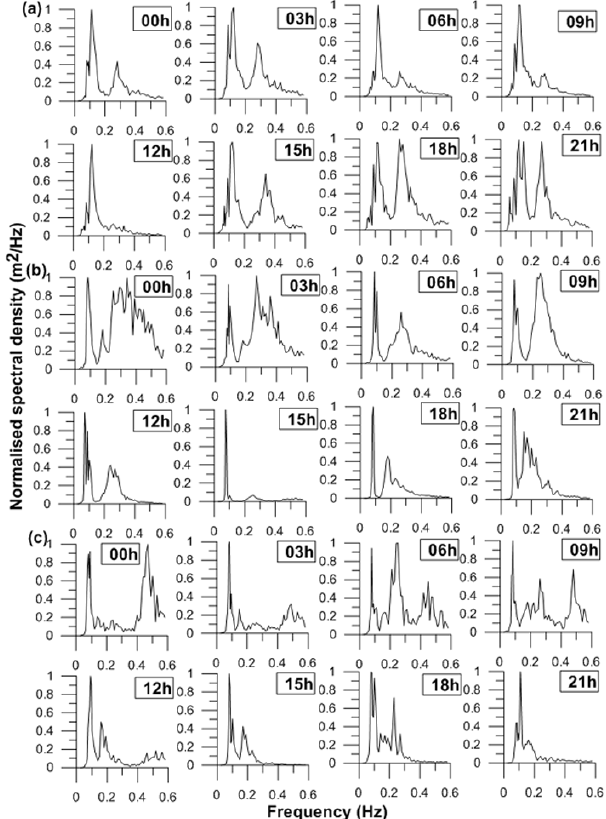
Fig. 2. Wind parameters (wind speed and direction) and significant wave height (total sea – black, swell – blue and wind sea – red) off Goa, Ratnagiri and Dwarka. Vertical lines from 1 to 6 in wind and wave parameters off Ratnagiri are related to shamal events.